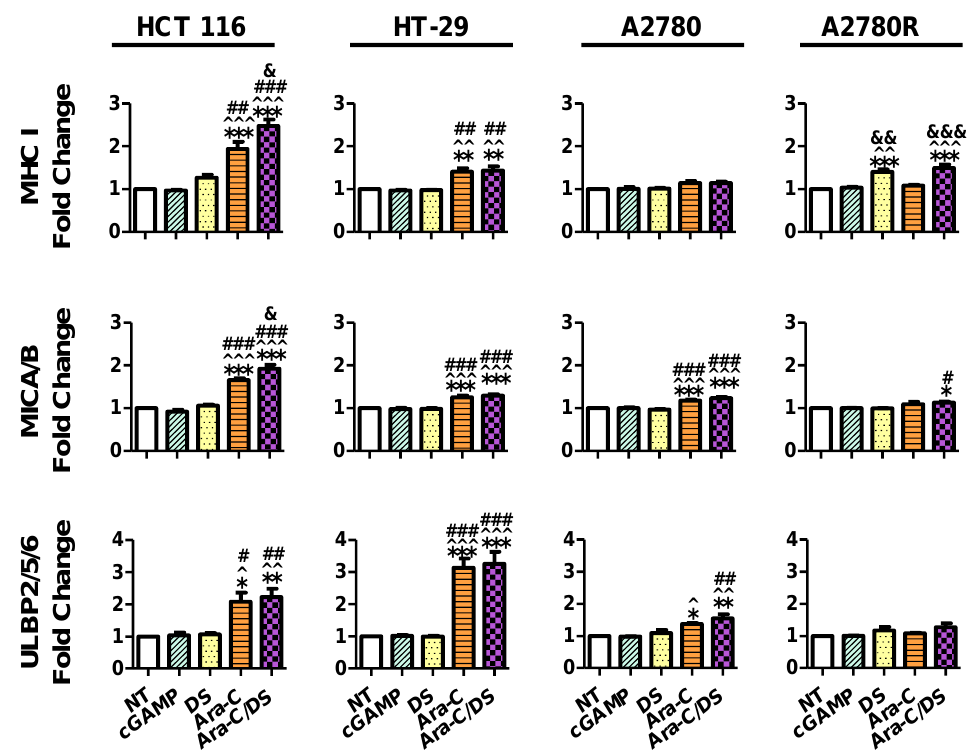
Figure 7. Change in surface expression of T and NK cell ligands following Ara-C/DS treatment. Cells were treated with Ara-C/DS, its components (50 nM Ara-C, 1 µg/mL DS) or cGAMP (1 µg/mL) for 48 h prior to analysis of MHC I, MICA/B and ULBP2/5/6 surface expression by flow cytometry (fold change calculated relative to non-treated cells, data represented as the average of three independent experiments, ± SEM). Statistical analysis performed with a one-way Anova with a Tukey’s HSD where *** p < 0.001, ** p < 0.01 and * p < 0.05 as compared to non-treated (NT), ˆˆˆ p < 0.001, ˆˆ p < 0.01 and ˆ p < 0.05 as compared to cGAMP, ### p < 0.001, ## p < 0.01 and # p < 0.05 as compared to DS,